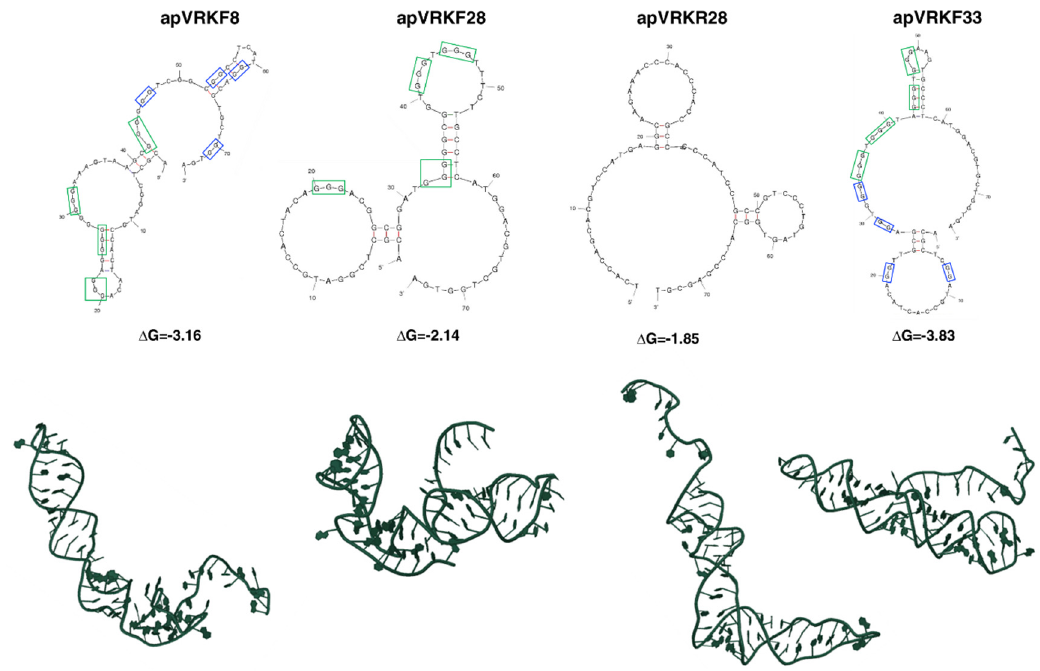
Figure 2. Secondary and tertiary structures of VRK1 aptamers. The structures were obtained using mFold, QGRS mapper and RNAcomposer software. The secondary structures with the lowest free energy and the proposed tertiary structures (centroid fold) are shown. Blue and green squares indicate G-doublets or G-triplets with highest probability (G-Score) of participating to the G-quadruplex formation, based on the algorithm used by QGRS-mapper software.